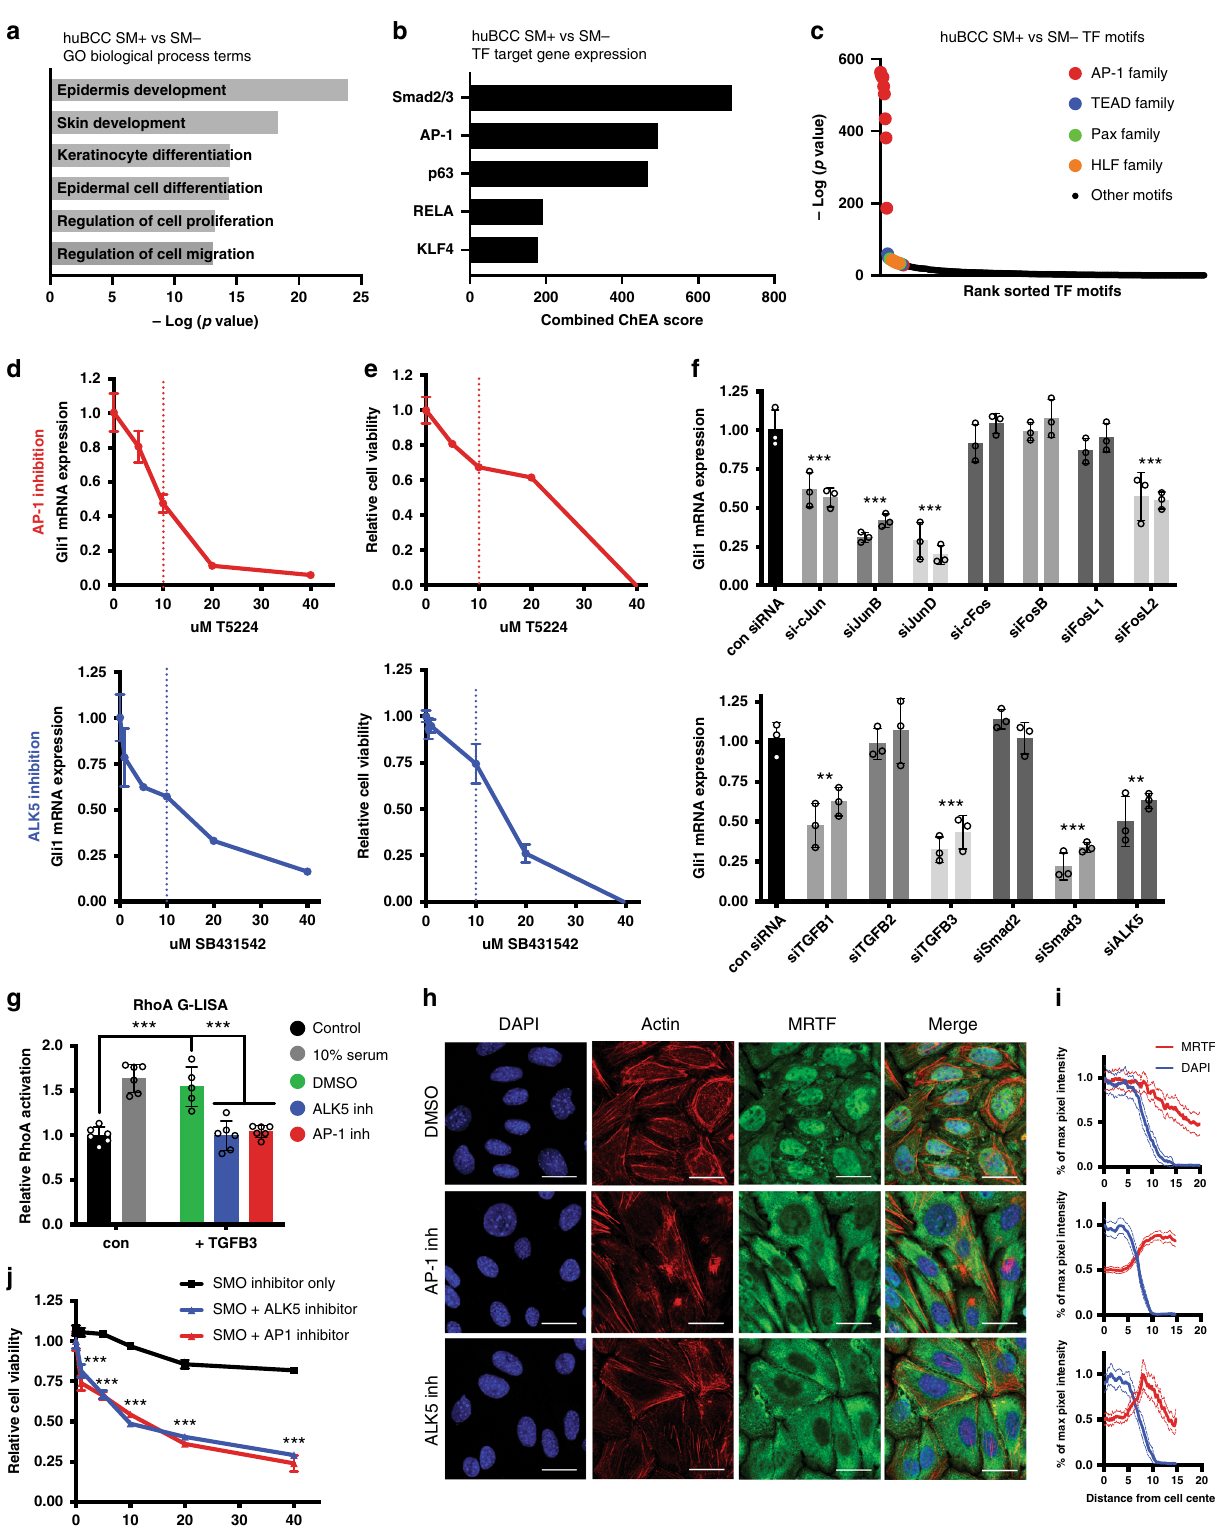
epistatic studies using small-molecule inhibitors or siRNA knock- downs at various stages of the pathway (Fig. 4i) simultaneously paired with overexpression constructs, measuring Gli1 expression as the fi nal output (Fig. 4j, Supplementary Fig. 4d, e). Treatment